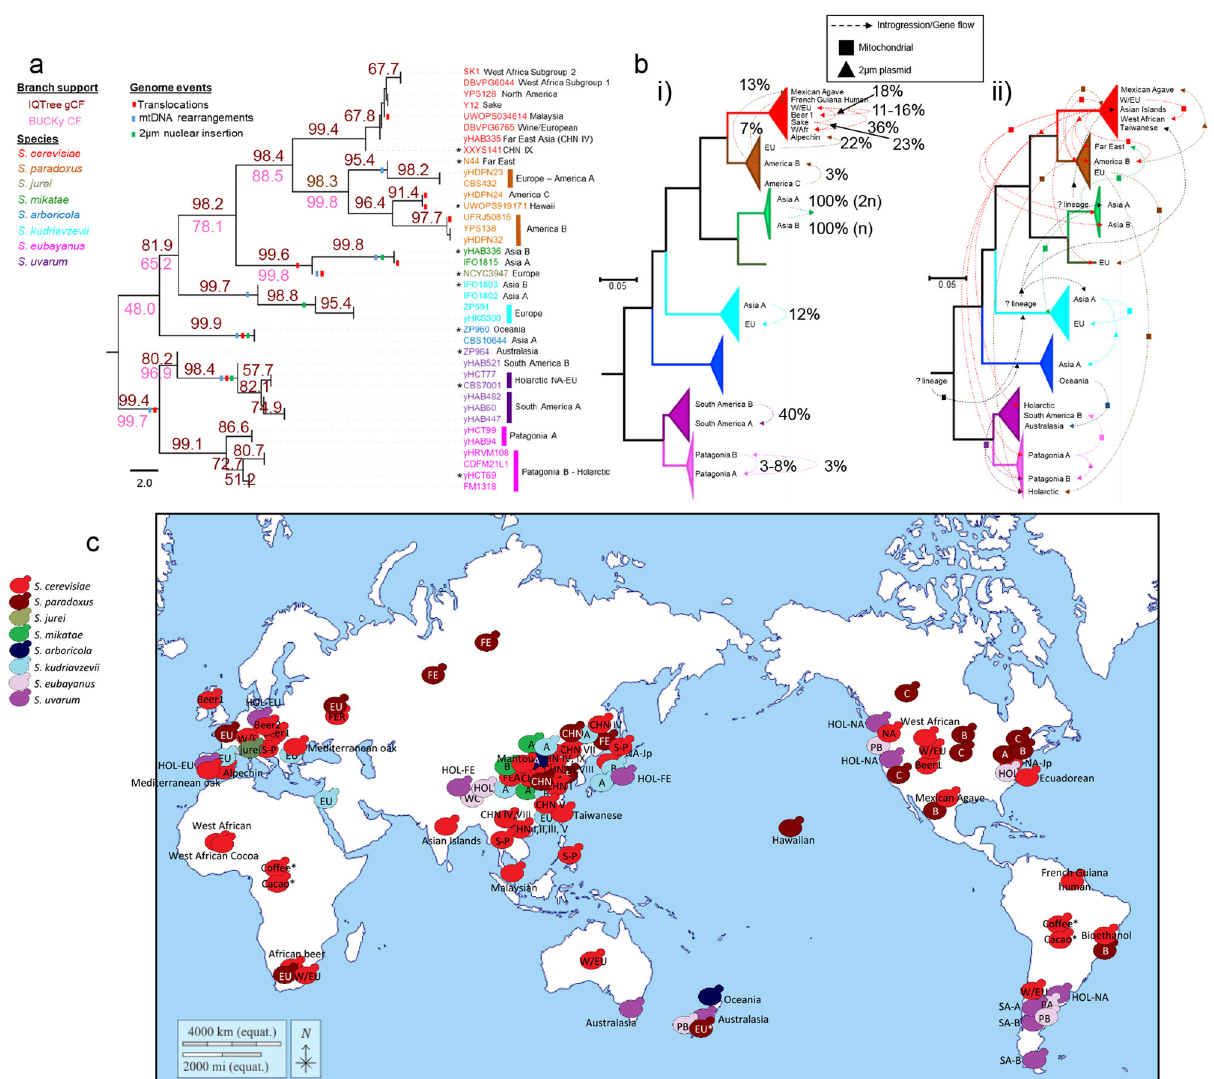
fl oworintrogressionbased onthegenome-wideanalysis. bi Summaryof detected nucleargene fl ow(betweenpopulations)and introgression(betweenspecies). The quanti fi ed percent of genome contribution by the donor is indicated near to the dashed arrow. Saccharomyces cerevisiae introgressions were congruent with pre- vious reports 13,19,66 . b ii summary of detected gene fl ow and introgression for the mitochondrial genome (squared symbol) and 2- µ m plasmid (triangle symbol). The direction of the arrow points to the recipient lineage.Unknown donorlineages are colored in black in b ii ). Branches and arrows are colored according to the species designations of their donors. Quanti fi cation of gene fl ow/introgression in cyto- plasmic genomes is not provided due to the low number of completed genome assemblies for these genomes. c Geographic locations of the different wild Sac- charomyces populations. The locations of populations, for which strains were not studied here, are indicated with an asterisk symbol. Yeast symbols are colored according to the species designation according to the left legend, and the popu- lationiswritten.Mapfromhttps://d-maps.com/carte.php?lib=world_paci fi c_ocean_ centered_map&num_car=3226&lang=en under d-maps.com